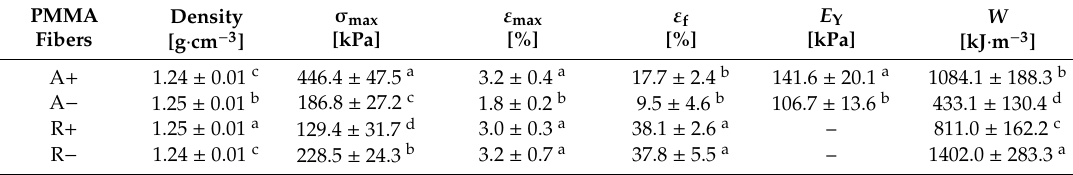
Table 1. Density and mechanical properties of PMMA membranes with σ max tensile strength, E Y Young’s modulus, W toughness, ε max strain at max strength, ε f at failure. All the presented values are the average ± standard deviation. a,b,c,d indicates statistical significance between each